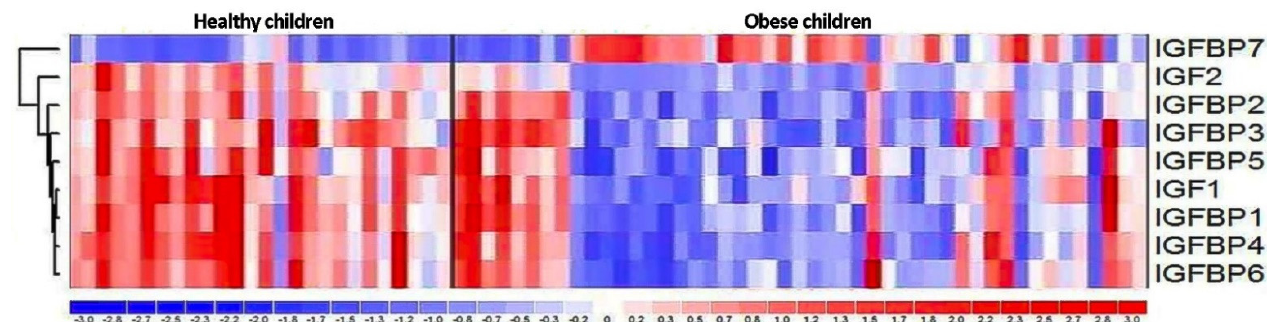
Figure 3. The hierarchical clustering showing differences in the expression patterns of IGF-axis genes between healthy control and obese groups.